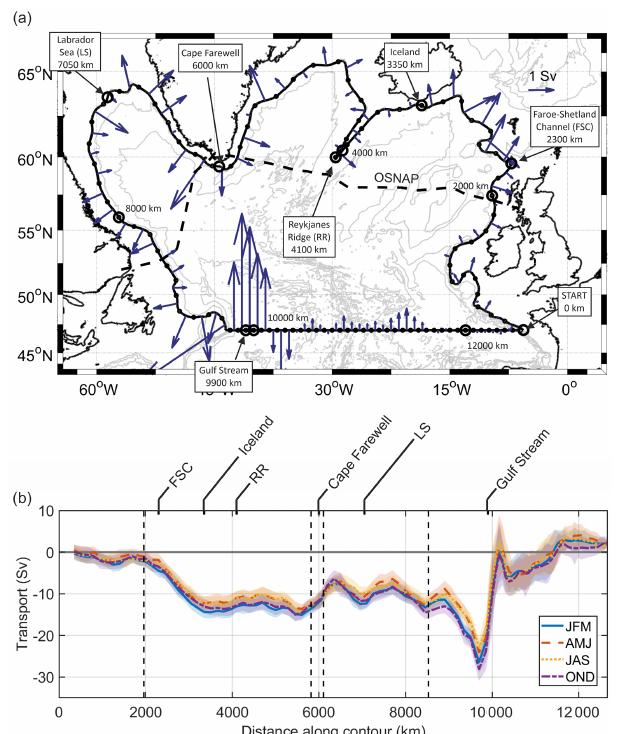
Figure 6. Surface Ekman transport perpendicular to contour, into the SPG positive. (a) volume transport between 0 and 1000m for each grid cell, coloured by season. Quiver arrows show magnitude of transport across grid cell, and are constrained to be perpendicular to the section. Horizontal bins are 150km apart around the 1000m contour, and 1 ◦ across 47 ◦ N. Bathymetry contours are from Gen- eral Bathymetry Chart of the Oceans (GEBCO; http://www.gebco. net/, last access: 15 June 2020). (b) Cumulative volume transport around the basin for each season. Key locations around the bound- ary are labelled as in Fig. 3, and vertical dashed lines denote OS- NAP